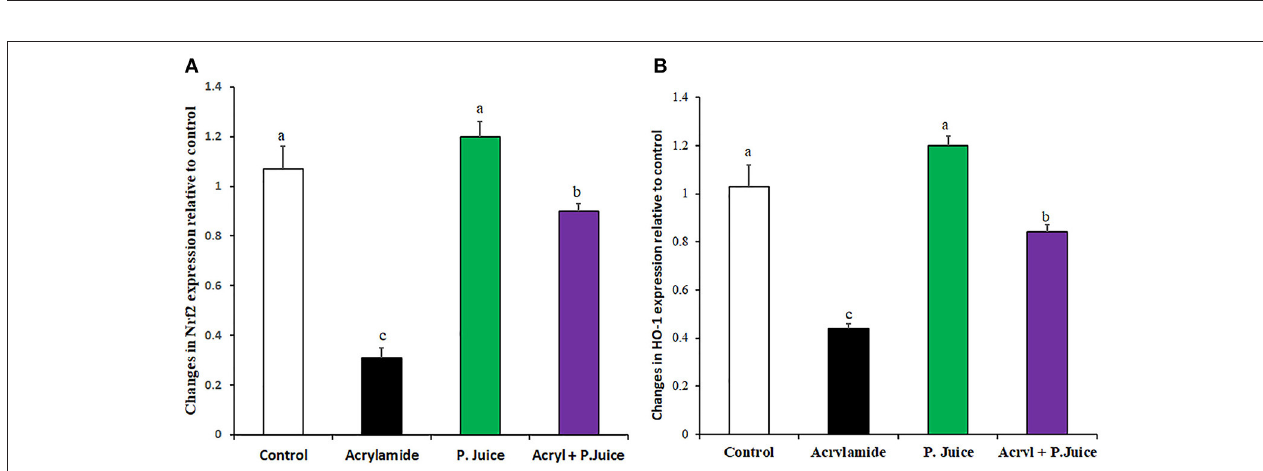
FIGURE 2 | Gene expression of oxidative stress marker genes Nrf2 (A) and HO-1 (B) in response to ACR and the TPJ in rat liver. Values are expressed as means ± SE. Means with different letters are significant ( p <